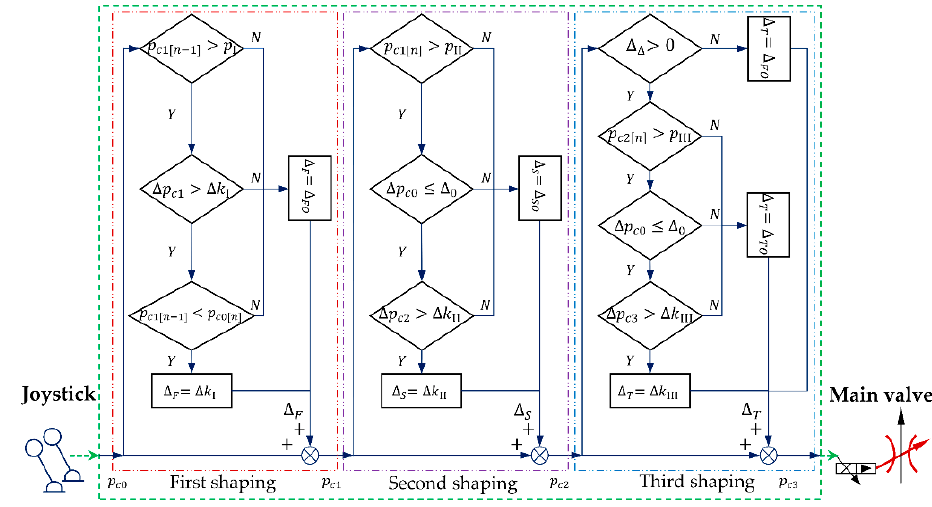
Figure 7. Main valve input shaping control logic.